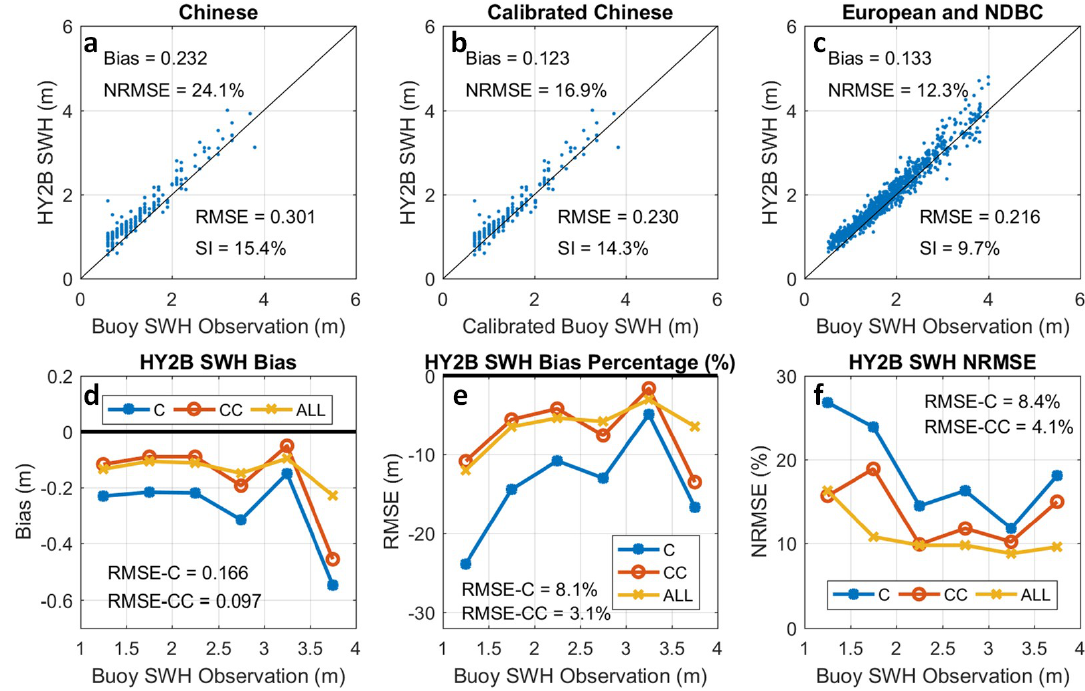
Figure 6. The validation of HY2B SWH against buoys from the calibrated and original Chinese buoys and European / NDBC buoys. ( a – c ) indicate the scatters and the statistical parameters; ( d ) indicates the bias distribution with the SWH value; ( e ) indicates the percentage of bias in each SWH range; ( f ) shows the NRMSE distribution with the SWH value. Among ( d – f ), the legends C, CC and ALL represent Original Chinese buoy SWH, Calibrated Chinese buoy SWH and European / NDBC buoy SWH, respectively.